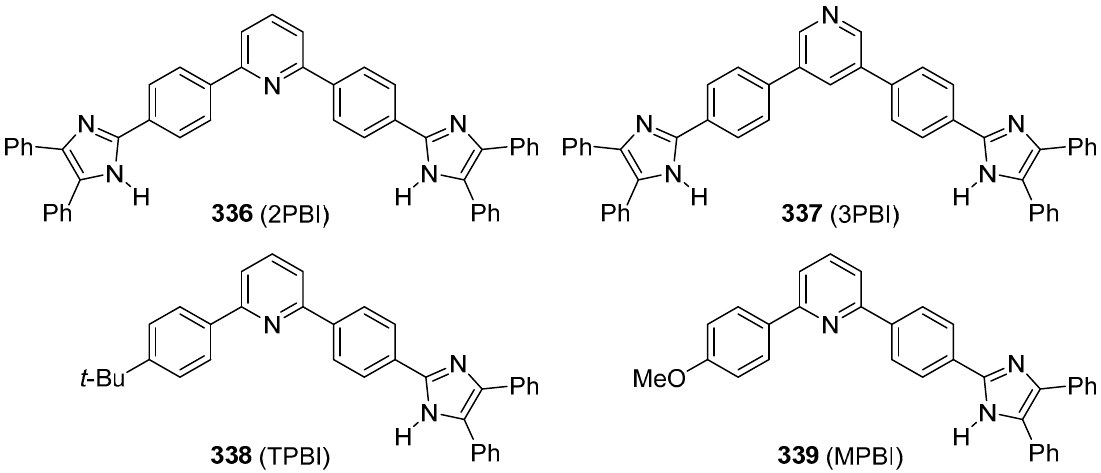
Figure 12. Structures of imidazole-pyridine fluorophores 2PBI ( 336 ), 3PBI ( 337 ), TPBI ( 338 ), and MPBI ( 339 ).